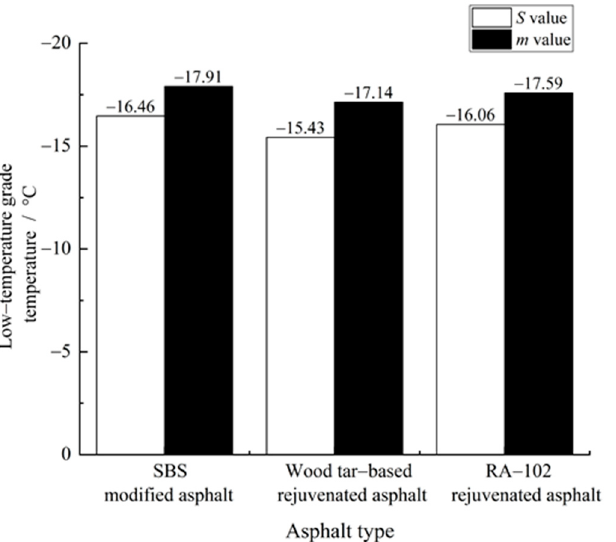
Figure 6. Calculation results of continuous low ‐ temperature classification temperature of each as ‐